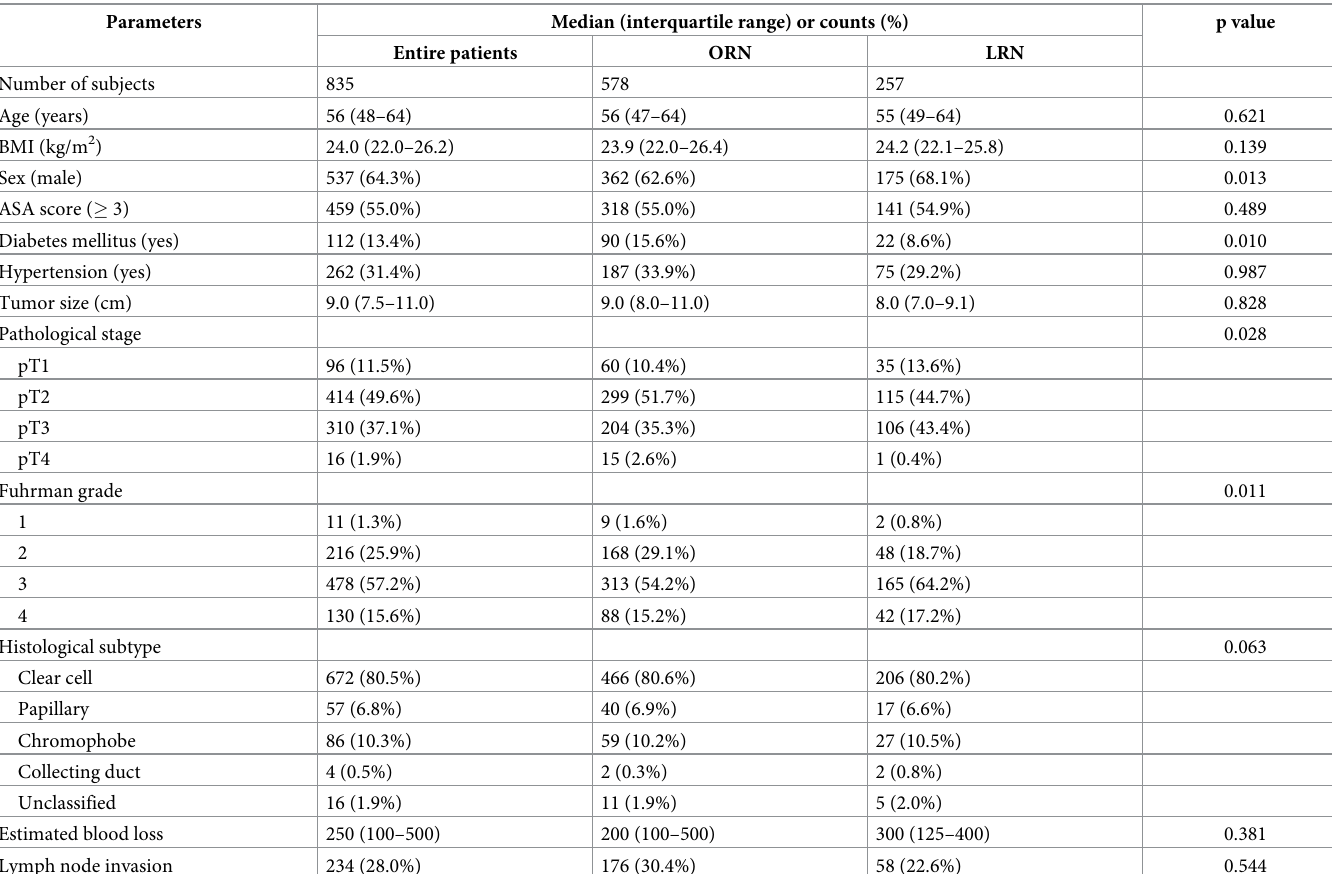
Table 1. Comparison of the clinicopathological characteristics of the entire patients who underwent radical nephrectomy, according to surgery type.